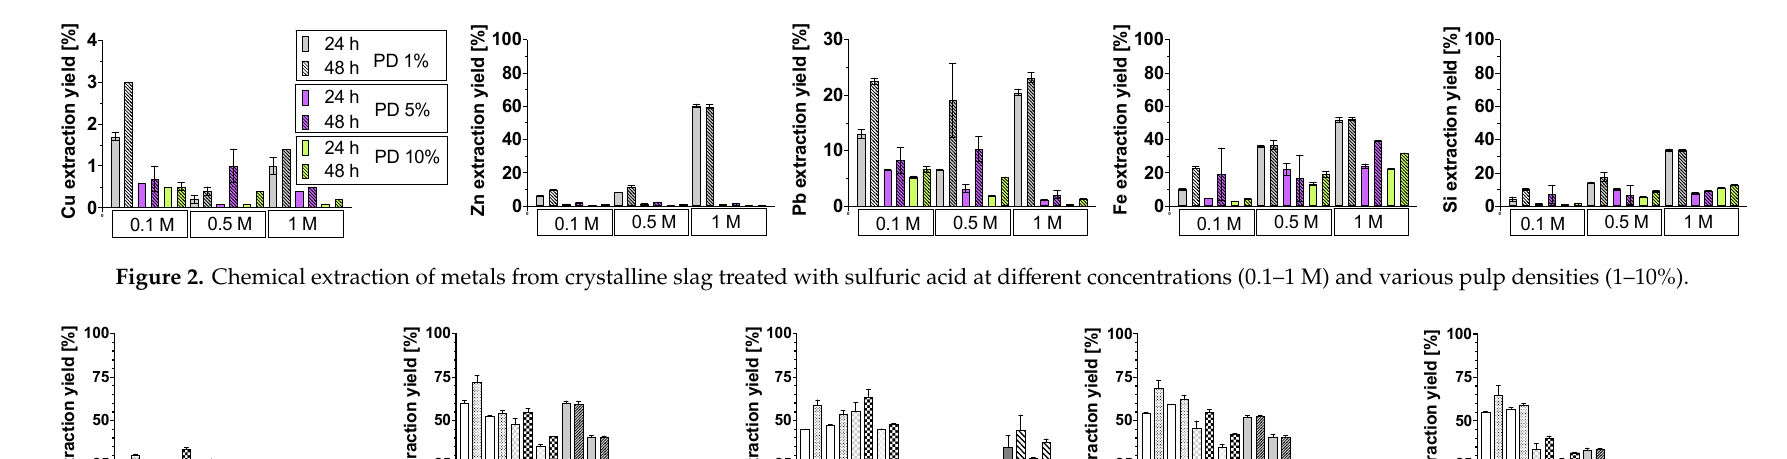
Figure 1. Scanning electron microscope images and XRD patterns of fresh samples of crystalline ( upper pictures ) and amorphous slag ( bottom pictures ). Abbreviations: Fa: fayalite, Hc: hercynite, Qtz: quartz, Crs: cristobalite, Cu: metallic copper, Bn: bornite, Cc: chalcocite.